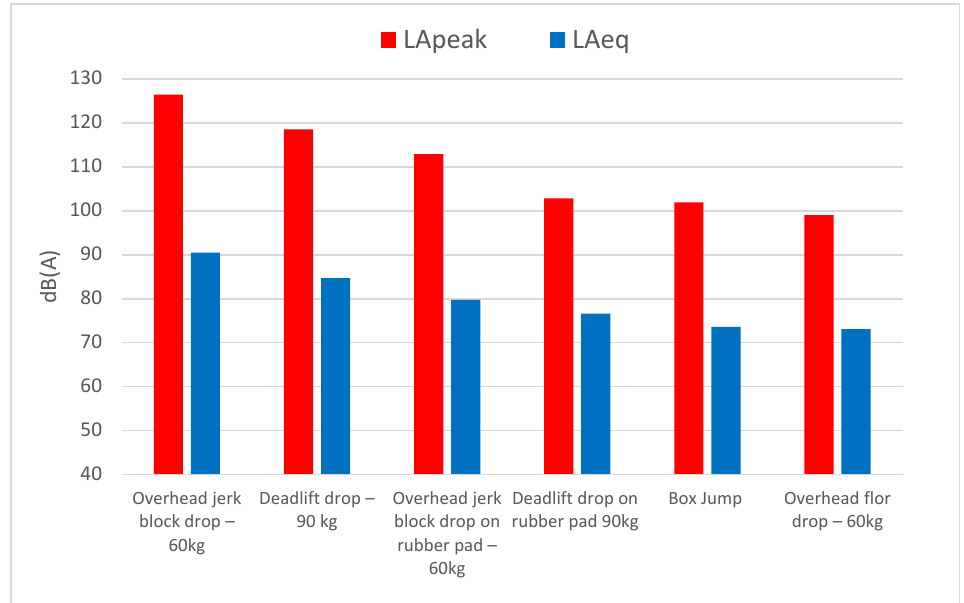
Figure 9. Classification of possible noise sources.